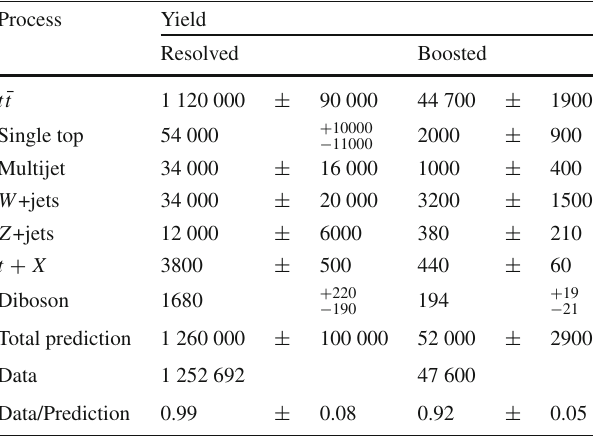
Table 4 Event yields after the resolved and boosted selections. Events that satisfy both the resolved and boosted selections are removed from the resolved selection. The cut on the kinematic fit likelihood has not been applied. The signal model, denoted t ¯ t in the table, was gener- ated using Powheg + Pythia8 , normalised to NNLO calculations. The uncertainties include the combined statistical and systematic uncertain- ties, excluding the systematic uncertainties related to the modelling of the t ¯ t system, as described in Sect.